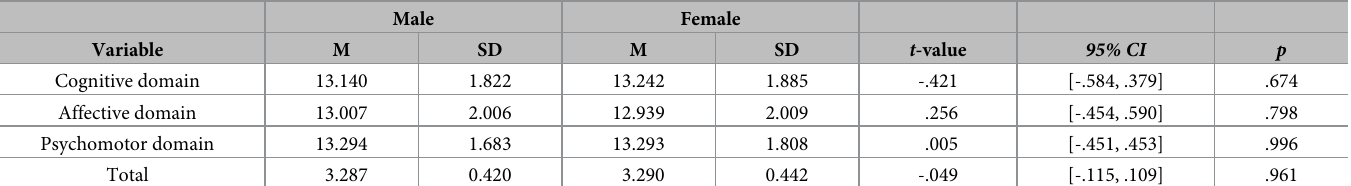
Table 4. Gender differences in L-SES